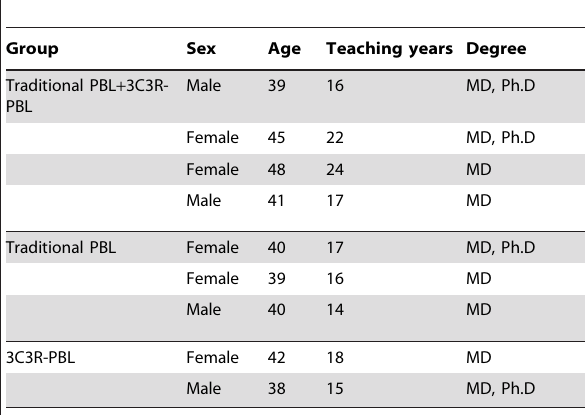
Table 1. Information about the